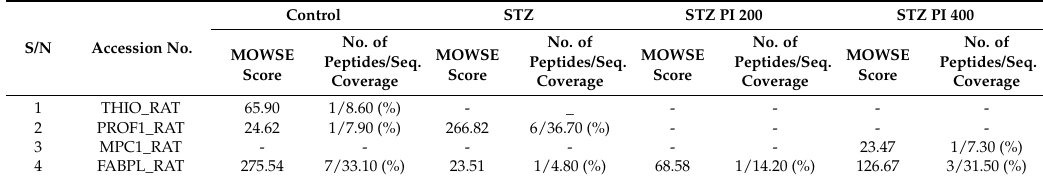
Table 2. Differentially expressed proteins identified from rat liver in each experimental group by nLC-MS.